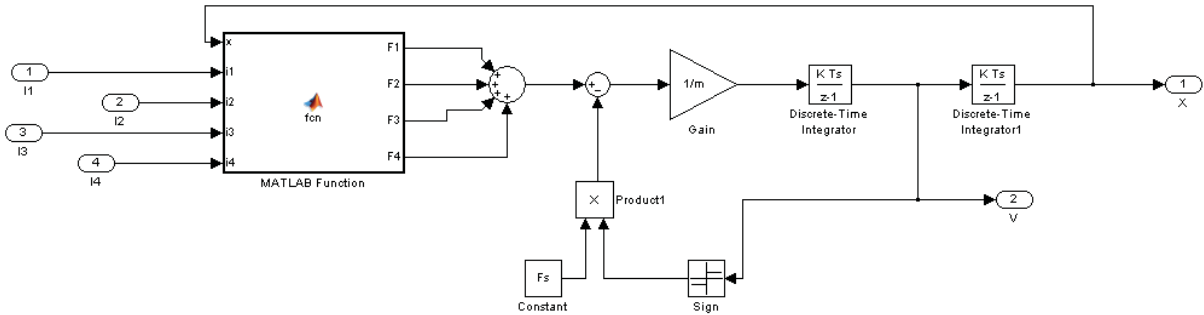
Figure 12. Content of the block diagram “LSRM (linear-switched reluctance motor) Mechanical